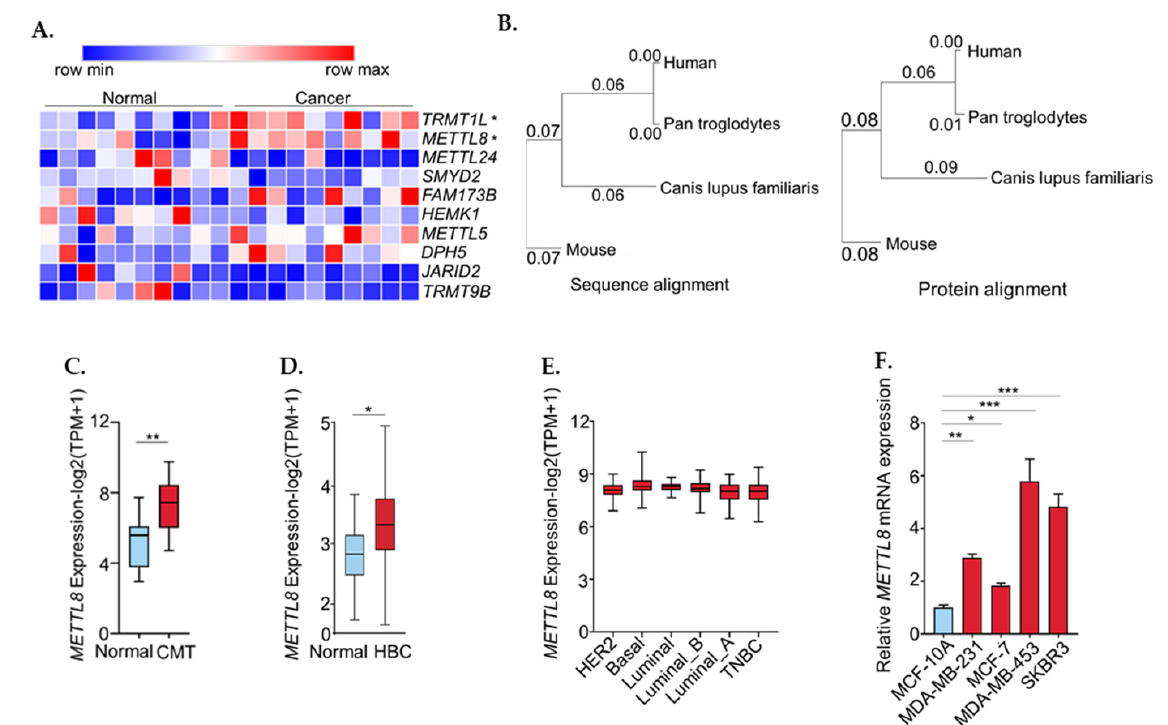
Figure 1. METTL8 expression in public dataset. ( A ) A list of 10 genes with significantly up-regulated expression in canine mammary tumor among 400 methyltransferases. Expression level of genes are represented as log2 (TPM+1). ( B ) METTL8 mRNA sequence and protein similarity between human and canine. ( C , D ) Boxplot showing relative expression of METTL8 in canine mammary tumor ( C ) and in breast cancer ( D ). ( E ) Boxplot showing relative expression of METTL8 in breast cancer subtype. ( F ) METTL8 transcript levels. Total RNA extracted from MCF-10A, MDA-MB-231, MDA-MB-453 and SKBR3 cells lines and subjected to RT-qPCR analysis for METTL8. * indicates p < 0.05, ** p < 0.01, and *** p < 0.001, CMT: canine mammary tumor, HBC: human breast